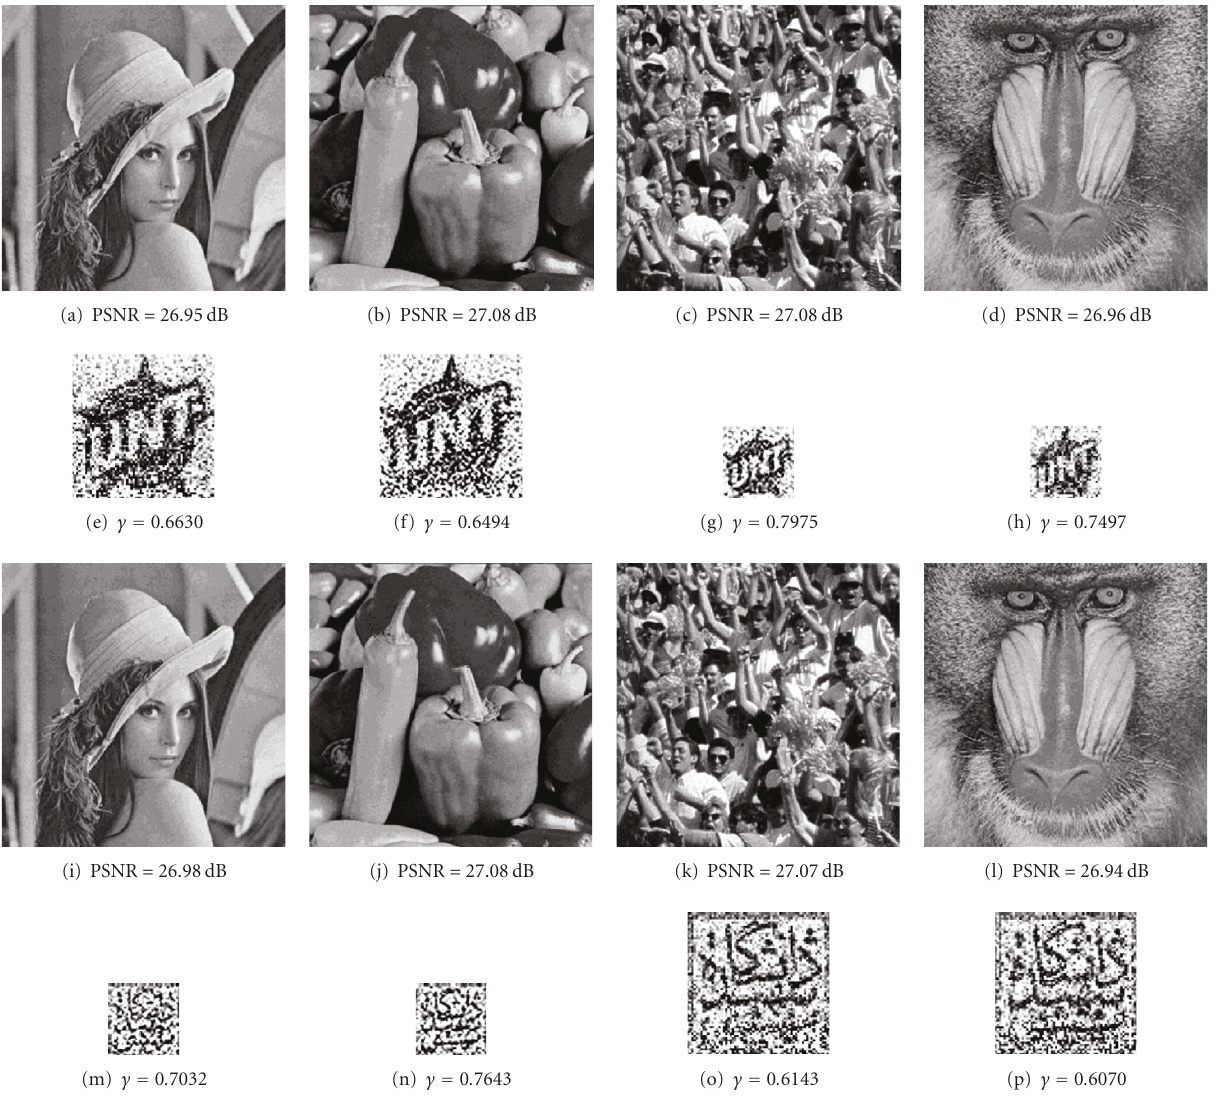
Figure 17: (a) and (b) Lena and Peppers watermarked imageswith 256 × 256 watermark image as shown in Figure 11(b) after adding Gaussian noise with mean = 0 and variance = 0.002, (e) and (f) the extracted watermarks with size 256 × 256 from (a) and (b), respectively. (c) and (d) Crowd and Baboon watermarked images with 128 × 128 watermark image as shown in Figure 11(b) after adding Gaussian noise. (g) and (h) The extracted watermarks with size 128 × 128 from (c) and (d), respectively. (i) and (j) Lena and Peppers watermarked images with 128 × 128 watermark image as shown in Figure 11(d) after adding Gaussian noise, (m) and (n) the extracted watermarks with size 128 × 128 from (i) and (j), respectively. (k) and (l) Crowd and Baboon watermarked images with 256 × 256 watermark image as shown in Figure 11(d) after adding Gaussian noise. (o) and (p) The extracted watermarks with size 256 × 256 from (k) and (l),